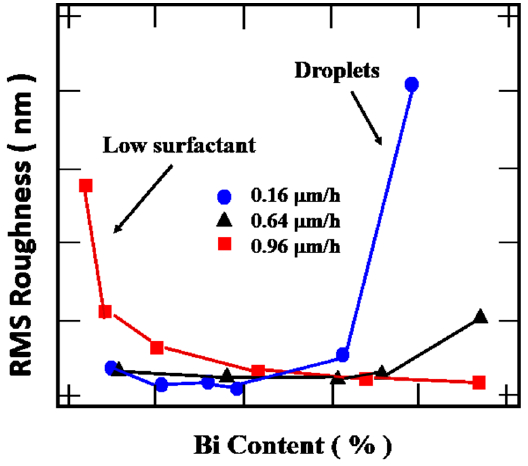
Figure 9. Root-mean-square (RMS) roughnesss values obtained from atomic force microscope (AFM) measurements for different growth rates and Bi compositions. Reproduced from Reference [129].